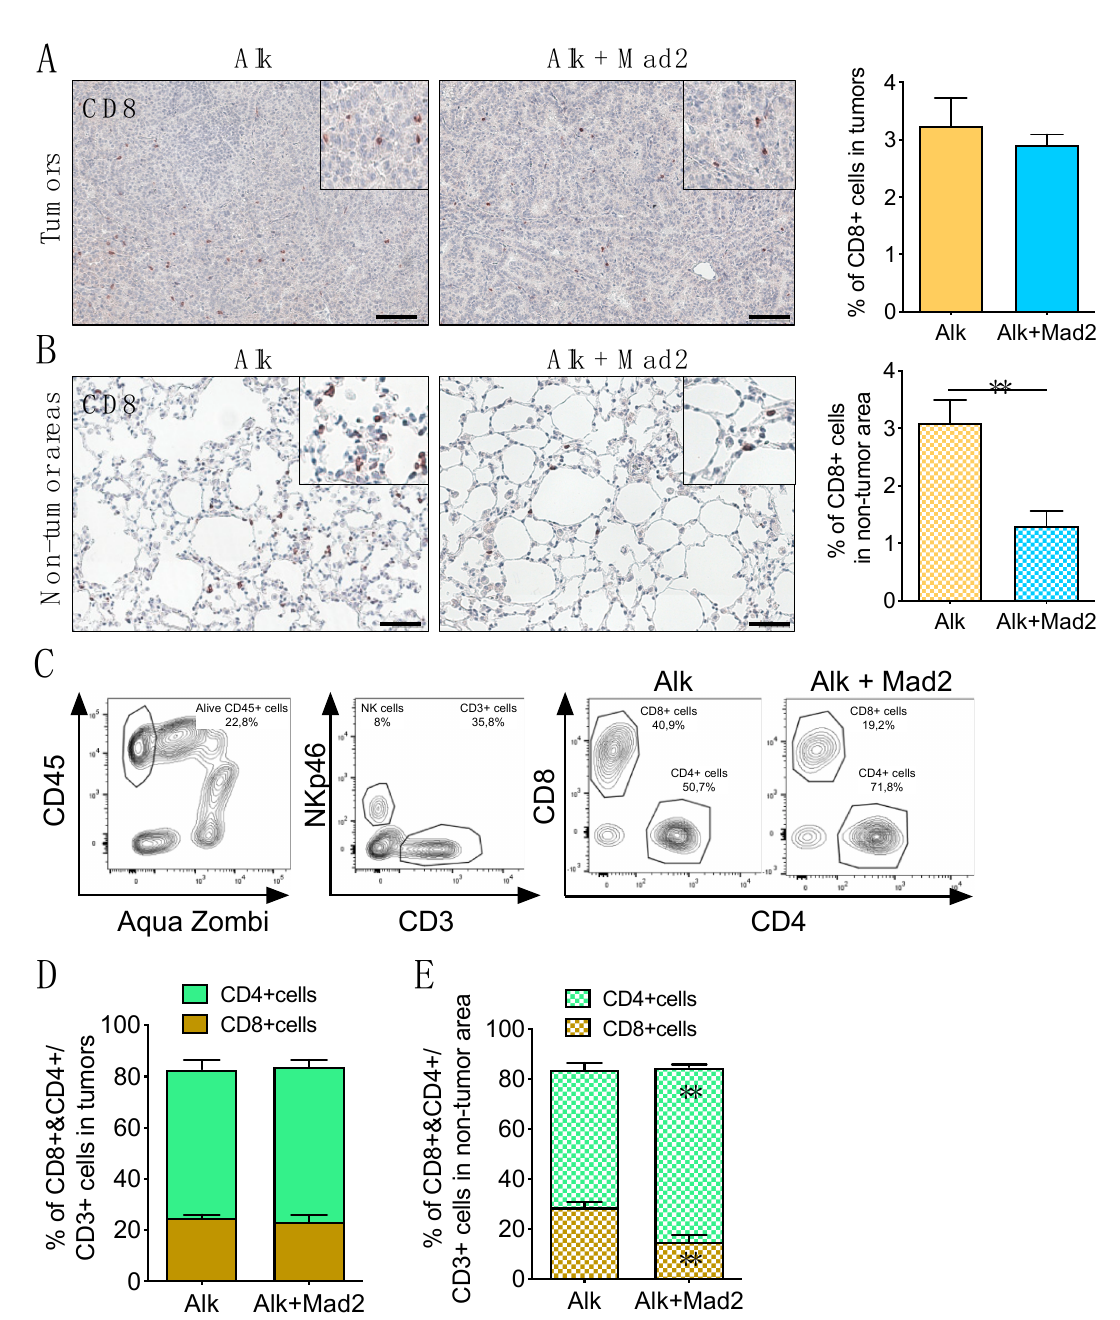
Figure 4. T cells and NK cells in Alk and Alk+Mad2 groups. ( A ) Representative images of CD8 T-cell infiltration in lung tumors and percentage of CD8 + cells in Alk and Alk+Mad2 mice ( n = 4). Scale bar:100 µ m. ( B ) Representative images of CD8 + cell infiltration in non-tumor areas and percentage of CD8 + cells in Alk and Alk+Mad2 mice ( n = 4). Scale bar: 50 μ m. ( C ) Representative flow plots of lung tumor and non-tumor areas, stained for CD45, NKp46, CD3, CD8, and CD4. ( D ) Percentage of CD8 + and CD4 + cells gated from CD45 + and CD3 + population in tumors (Alk; n = 10, Alk+Mad2; n = 6) and in ( E ) non-tumor areas (Alk; n = 10, Alk+Mad2; n = 6). ** p < 0.01; one-way ANOVA.